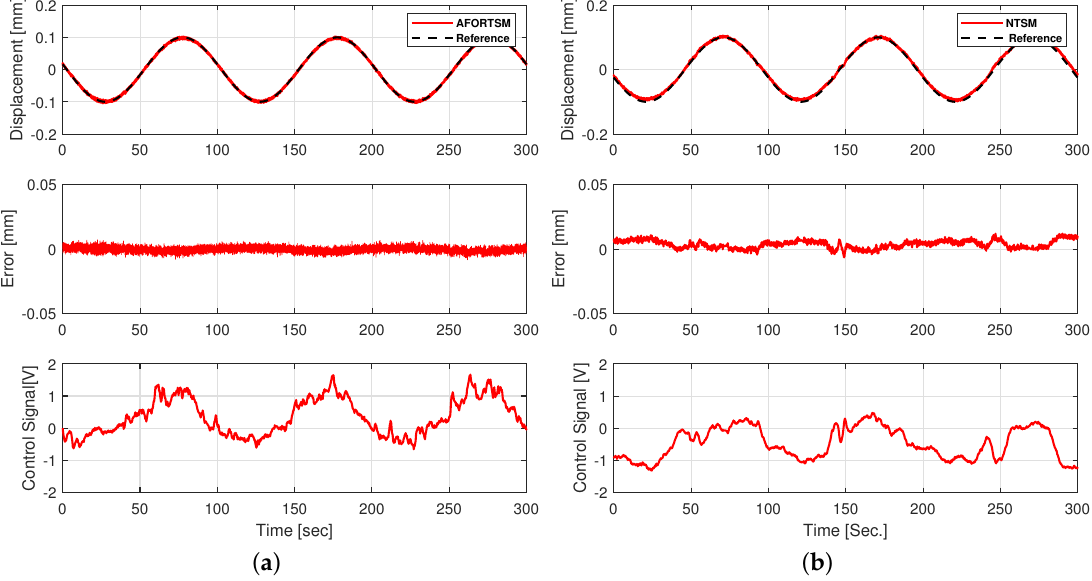
Figure 8. Test 7: Experimental results of AFORTSM and NTSM for tracking a single-tone sinusoidal reference with uncertainties (top: tracking profiles; middle: tracking error; bottom: control signal). ( a ) AFORTSM; ( b )